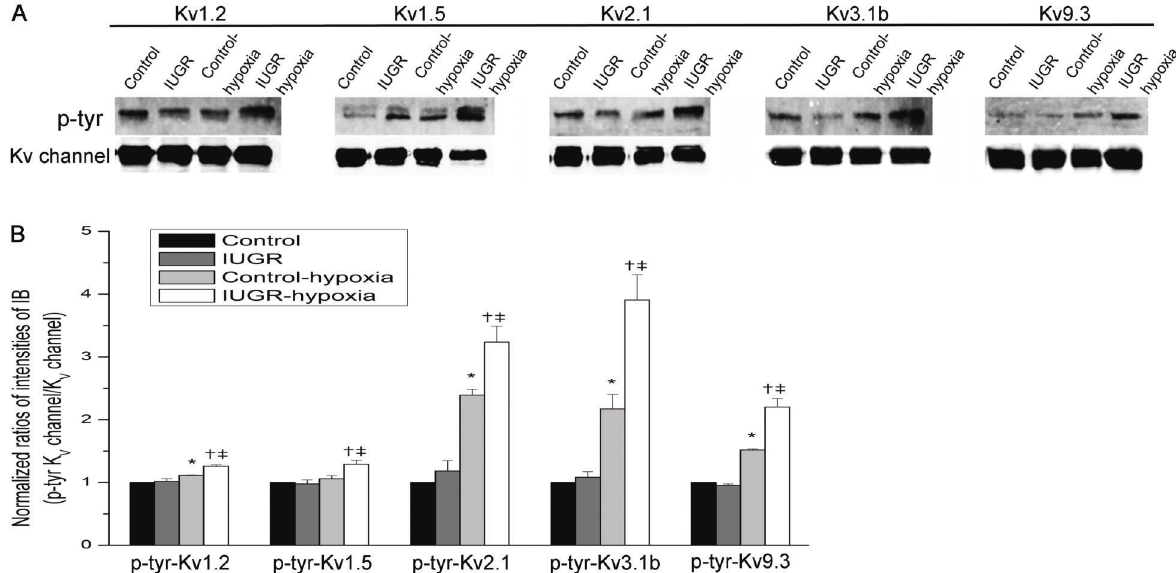
Figure 5. Co-immunoprecipitation analysis of the effect of hypoxia on tyrosine phosphorylation of Kv channels in pulmonary artery smooth muscle cells. A , Representative immunoblots of the a -subunit of Kv channels and their relevant phosphotyrosine (p-tyr). B , Summary histogram of immunoblot (IB) analysis of Kv channel p-tyr. Data are reported as means ± SD. *P o 0.05, control groups vs control-hypoxia groups; w P o 0.05 intrauterine growth retardation (IUGR) groups vs IUGR-hypoxia groups; = P o 0.05, control-hypoxia groups vs IUGR-hypoxia groups